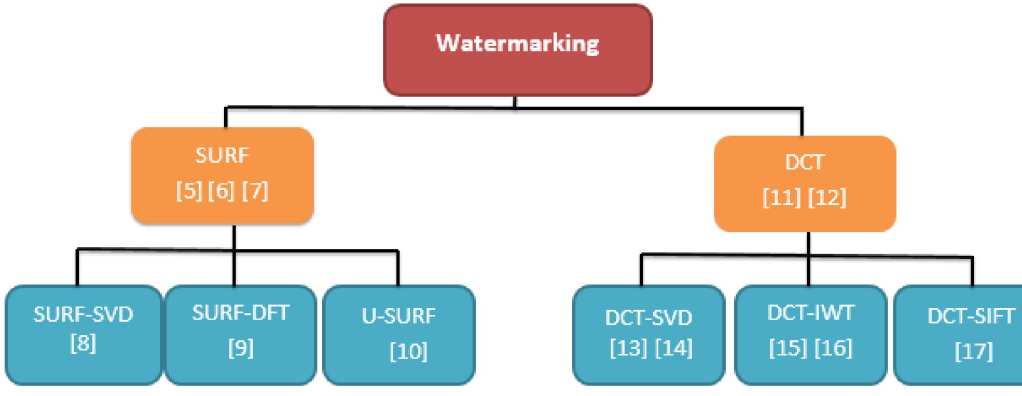
Fig 2. DCT watermarking transformation